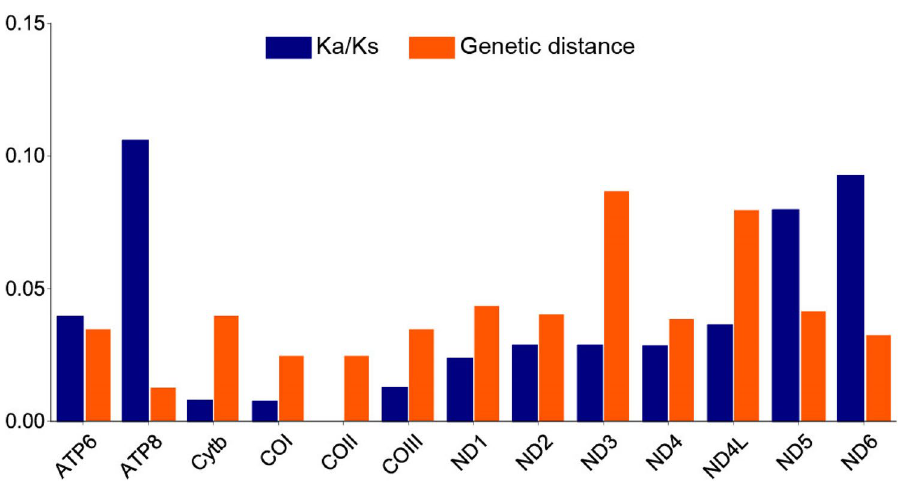
Figure 6. The ratios of Ka/Ks and genetic distances of each PCG among four Aythya